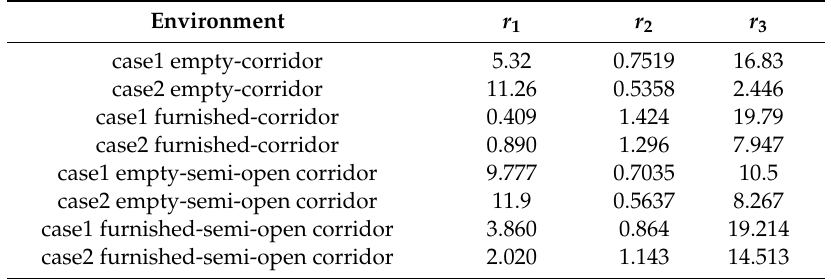
Table 4. Numerical modeling parameters for τ RMS in both corridor and semi-open corridor.